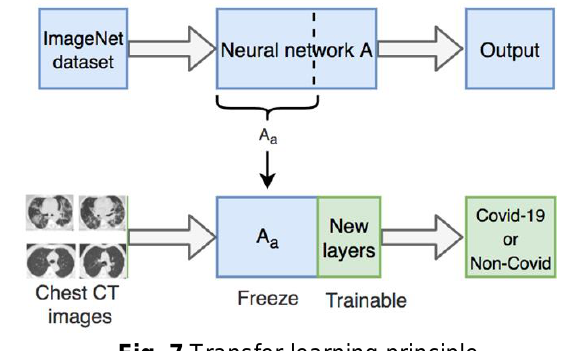
Fig. 7 Transfer learning